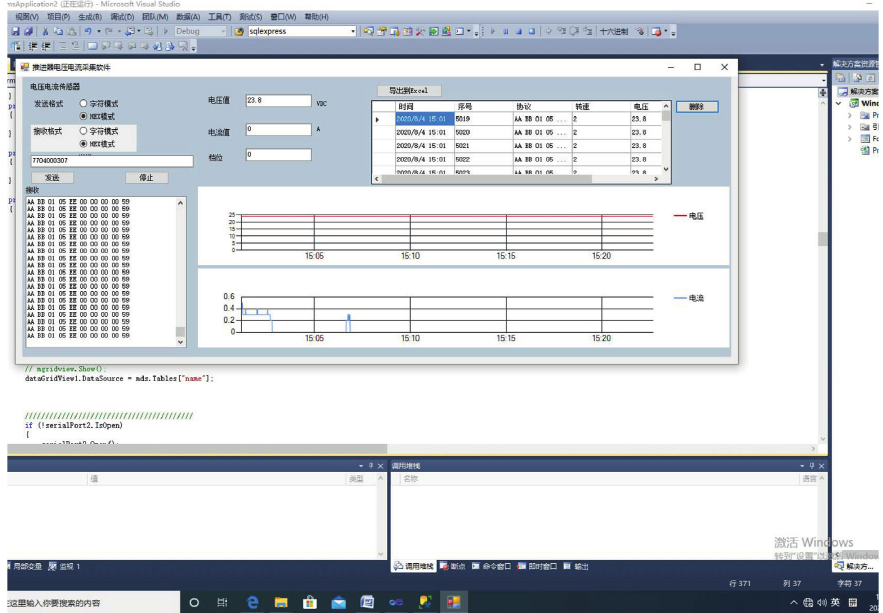
Figure 3: Upper computer software and collected